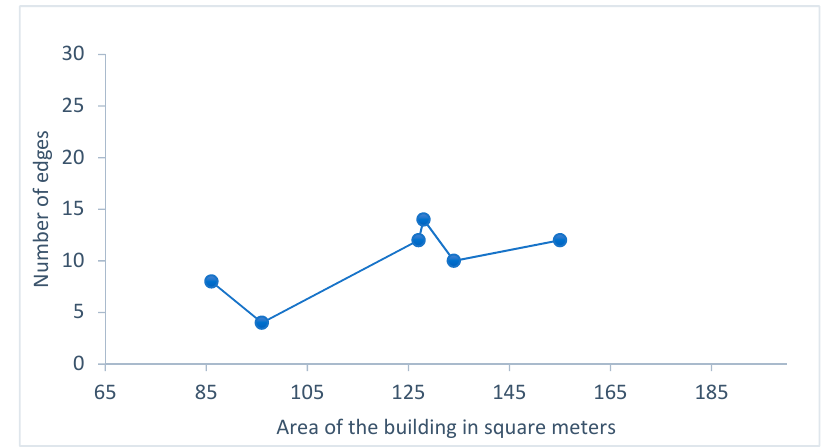
Figure 11. Efficiency of the method by Wang et al. [13], observed based on the number of edges that are necessary to draw the shape of the building boundary. Values in this research range from 4 to 14.